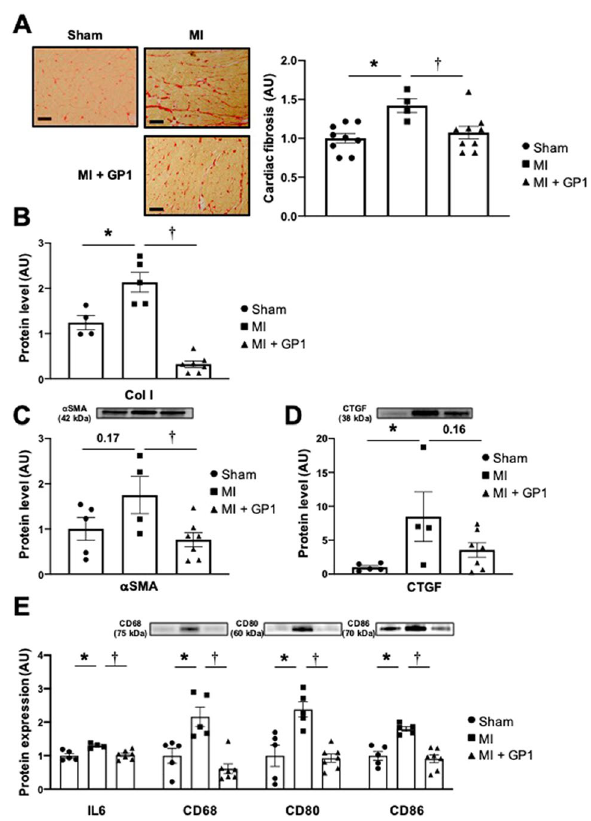
Figure 2. Effect of three months of GP1 (GPZ614741) administration. ( A ) Representative microphotographs and quantification of interstitial fibrosis. ( B ) Col I, ( C ) αSMA, ( D ) CTGF and ( E ) proinflammatory markers (IL6, CD68, CD80, and CD86) protein levels in Sham, MI, and MI + GP1 (GPZ614741)-treated mice. The full- length gel and bands are included in the Supplementary Fig. 11. *p < 0.05 vs . Sham. † p < 0.05 vs. MI mice.